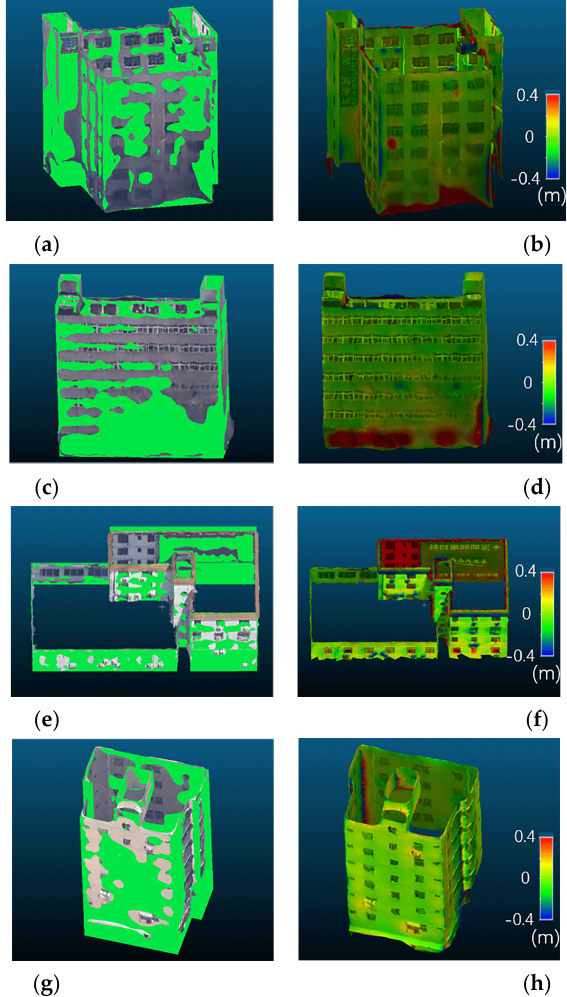
Figure 10. The minimum, maximum, and average errors of the four reconstructed 3D fa- Figure 9. The graphics of reconstruction errors for four buildings: ( a , c , e, and g ) façade model over- Figure 9. The graphics of reconstruction errors for four buildings: ( a , c , e , g ) façade model overlaid on çade models in order are 0.066, 0.154, and 0.09 m. laid on the original date; ( b , d , f, and h ) reconstruction error. the original date; ( b , d , f , h ) reconstruction error.